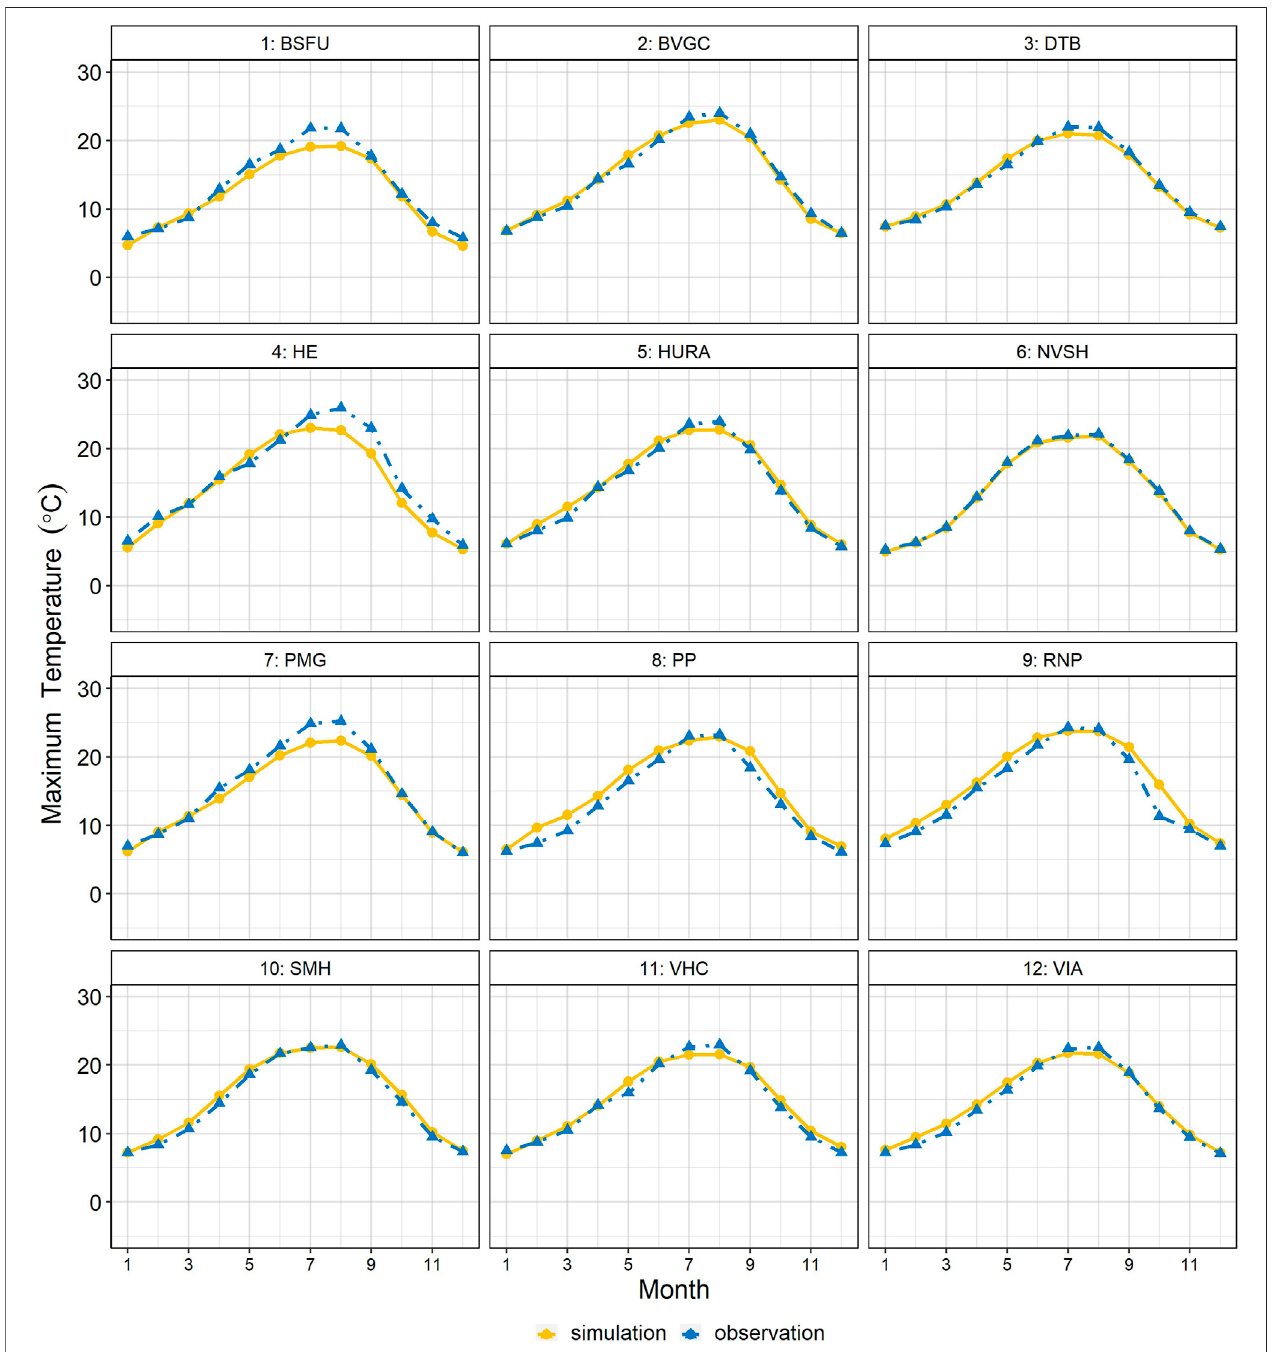
FIGURE 3 | Monthly comparisons between maximum temperature simulation and